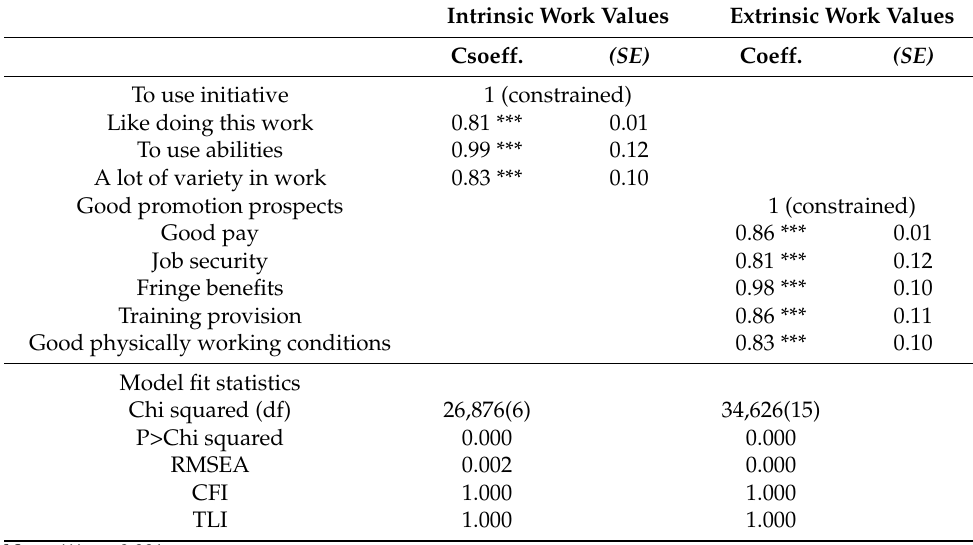
Table A1. Confirmatory Factor Analysis Model of Work